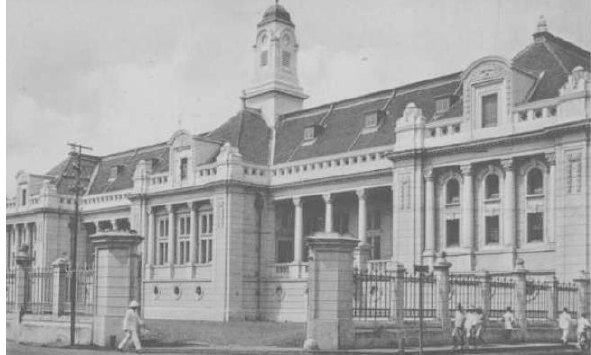
Figure 12. Javasche Bank, Batavia. Extract from Batavia- Weltevreden-Meester